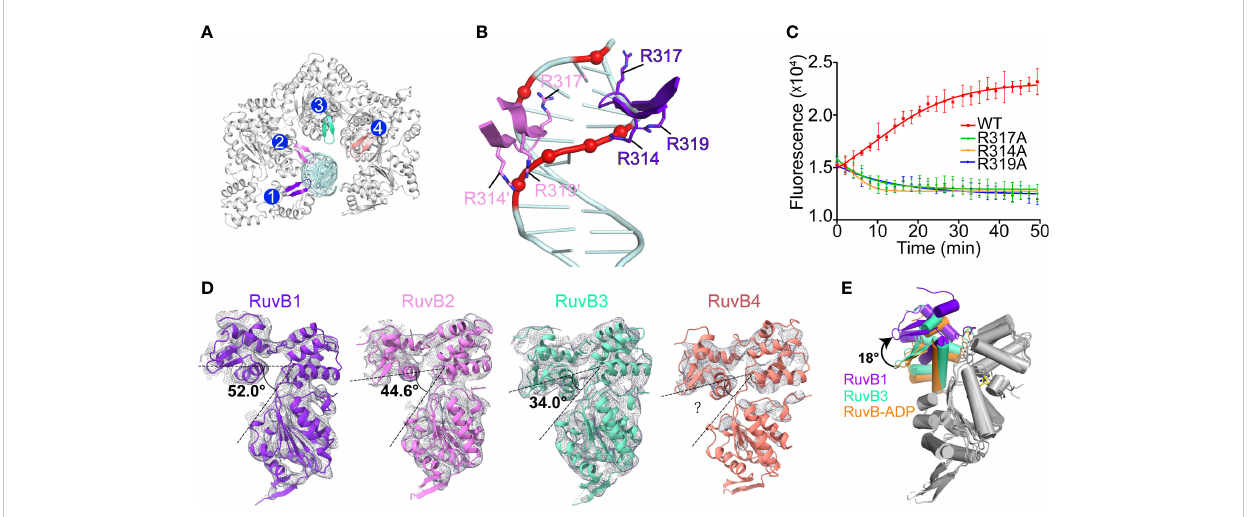
FIGURE 6 The interactions between PaRuvB and DNA. (A) Top-view of the structure of the RuvB-DNA complex. The DNA interacting elements of RuvB are highlighted in different colors. (B) Zoomed in view of the interactions between RuvB and DNA duplex. Key RuvB residues and DNA backbone phosphates are shown in sticks and spheres, respectively. (C) Effects of RuvB mutations on the branch migration activity of RuvAB complex (mean ± s.d., n = 3 independent experiments). (D) Conformational variations of RuvB subunits in the cryo-EM structure. RuvB subunits are aligned on their N- terminal domains and overlaid with 2mFo-DFc map contoured at 0.28 s . The angle between domains N and C is de fi ned by the C a atoms of G165- V186-T314. (E) Comparison of RuvB subdomain orientations between the cryo-EM structure and the ADP-bound crystal structure (orange). RuvBs are aligned on their N-terminal domains. ADP is shown in yellow stick.